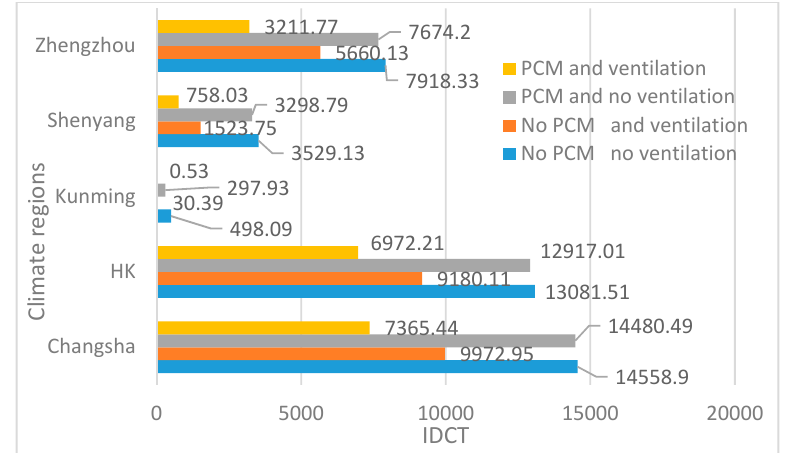
Figure 6. Summer I DCT of building models with different PCM and ventilation (Ventilating 1 ac/h from 8:00 to 18:00).